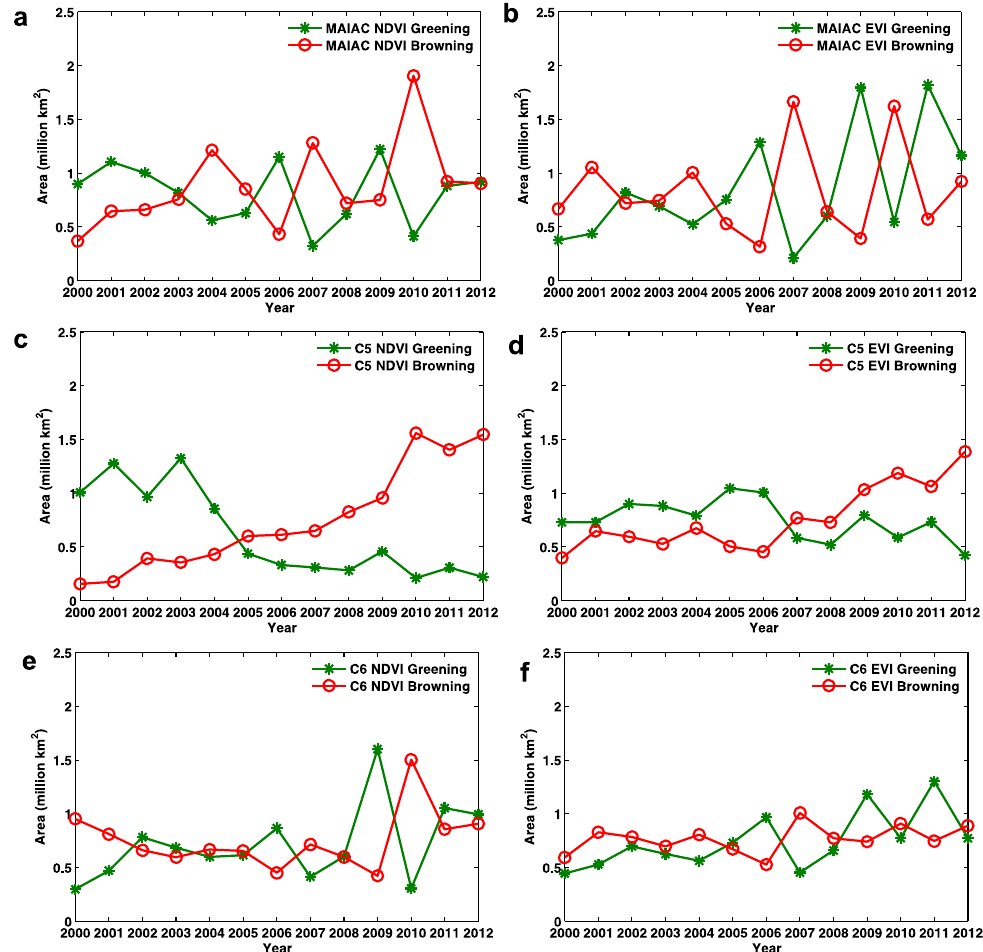
Figure 2. Time series of the area of greening and browning Amazon forests. Forests with greenness standardized anomalies greater than +1 are marked as greening forests; and forests with greenness standardized anomalies less than -1 are marked as browning forests. ( a ) Results from MAIAC NDVI data; ( b ) Results from MAIAC EVI data; ( c ) Results from Collection 5 MODIS NDVI data; ( d ) Results from Collection 5 MODIS EVI data; ( e ) Results from Collection 6 MODIS NDVI data; ( f ) Results from